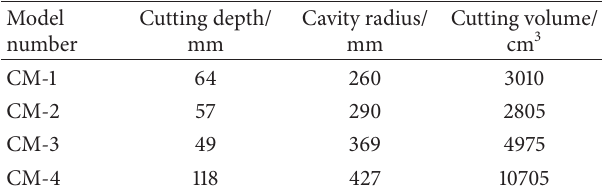
Table 2: Blasting effect of millisecond blasting model test.